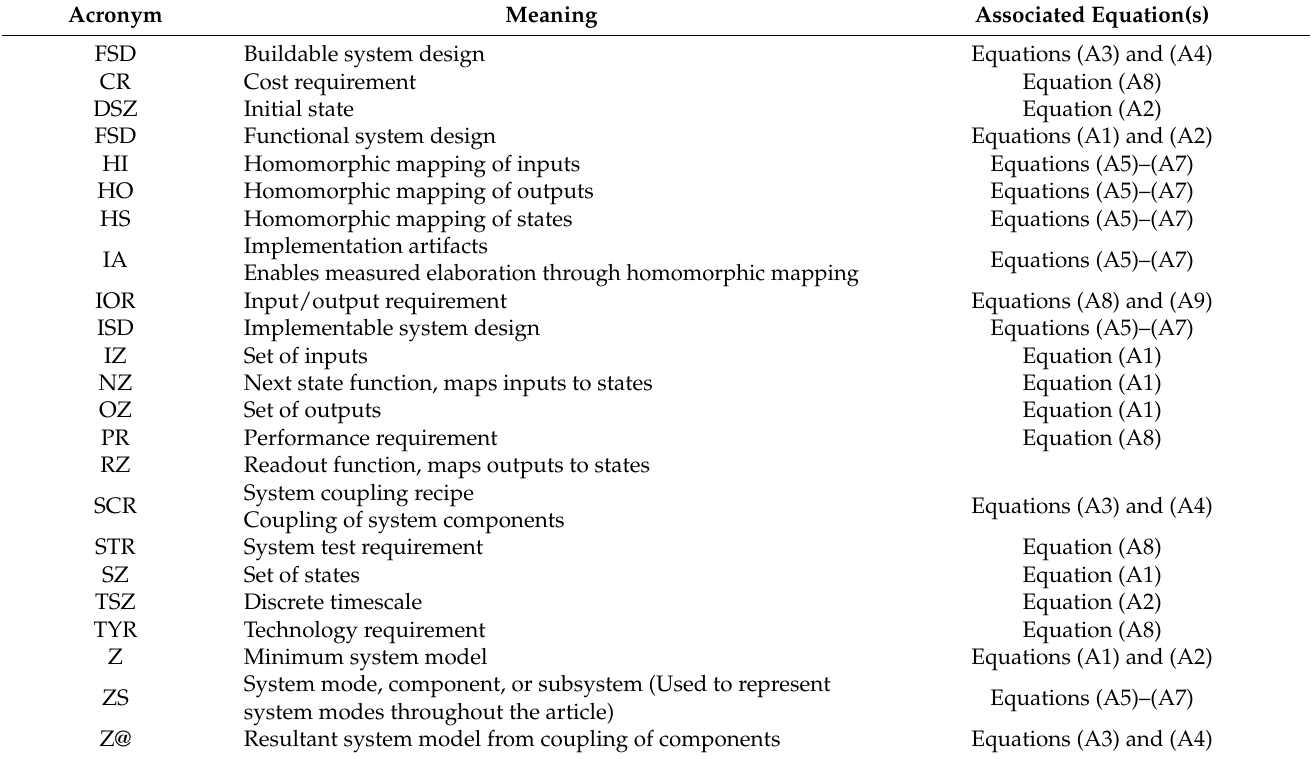
Table A1. The acronyms and their associated